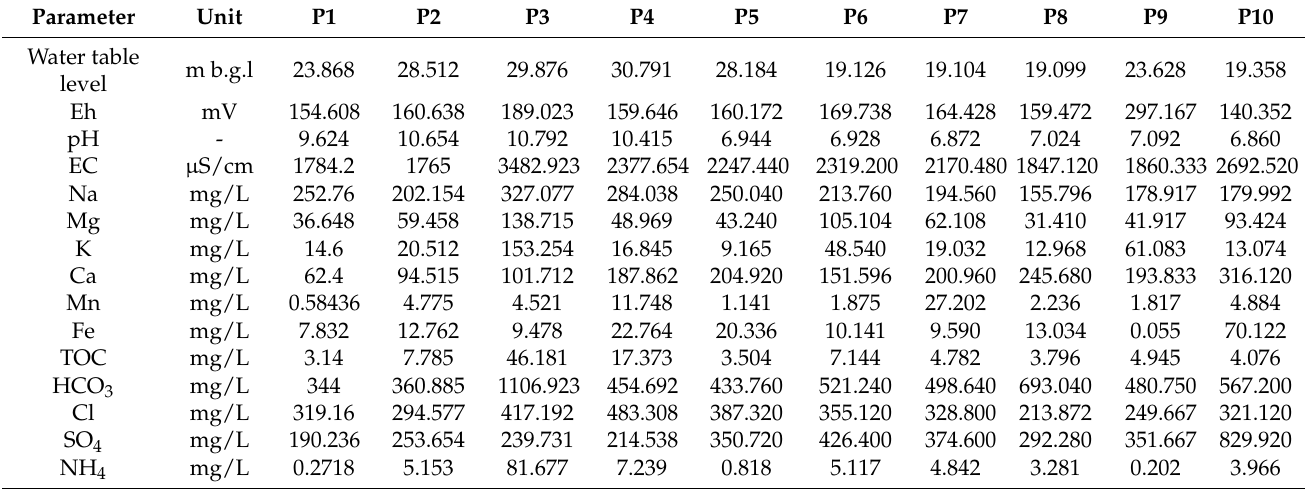
Table 1. Mean values of measured parameters in the monitoring